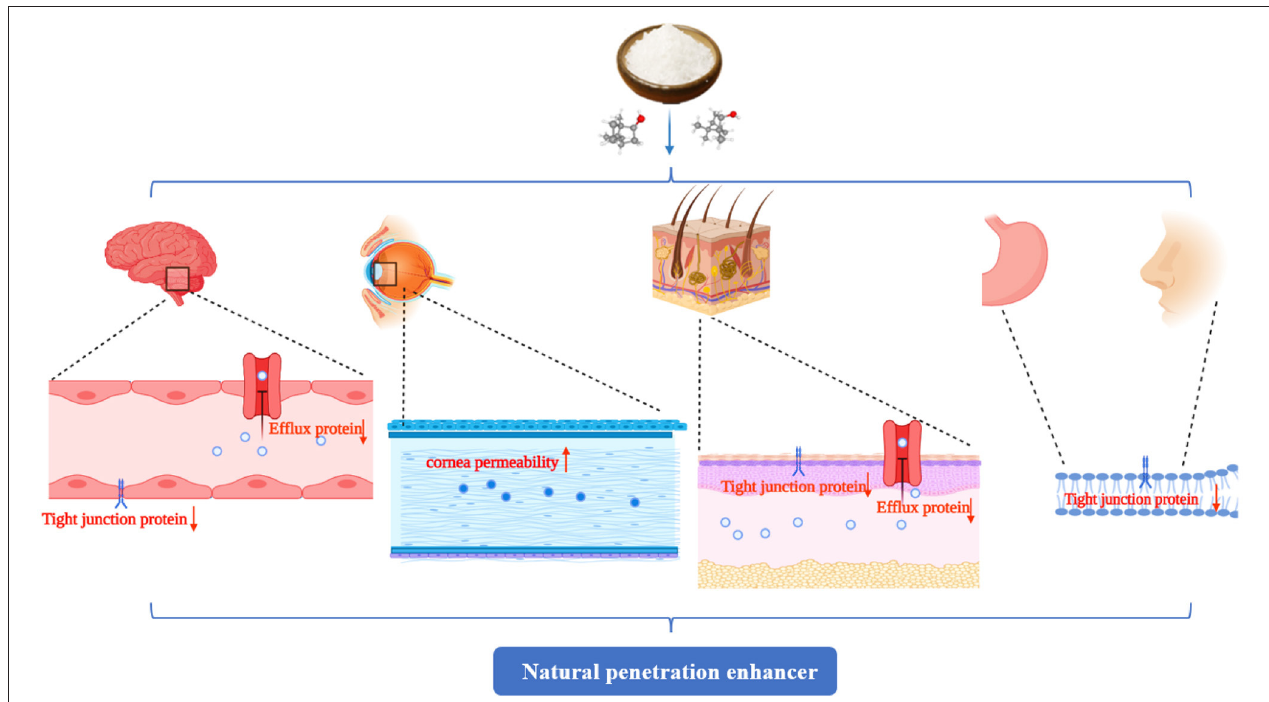
FIGURE 6 | The penetration promoting effect of borneol is mainly reflected in promoting drug penetration through the skin, gastrointestinal mucosa, nasal mucosa, corneal, and the blood-brain barrier (BBB). The main mechanisms involved changes in the arrangement of lipid molecules and increases in their fluidity, improved mucosal cell permeability, increased paracellular and intercellular transport, destruction of the tight junction proteins, opened the BBB, and inhibited the expression of drug-resistant proteins, such as multidrug resistance mutation 1 (MDR1) and P-glycoprotein (P-gp), to reduce the drug efflux. The figure was created by BioRender,